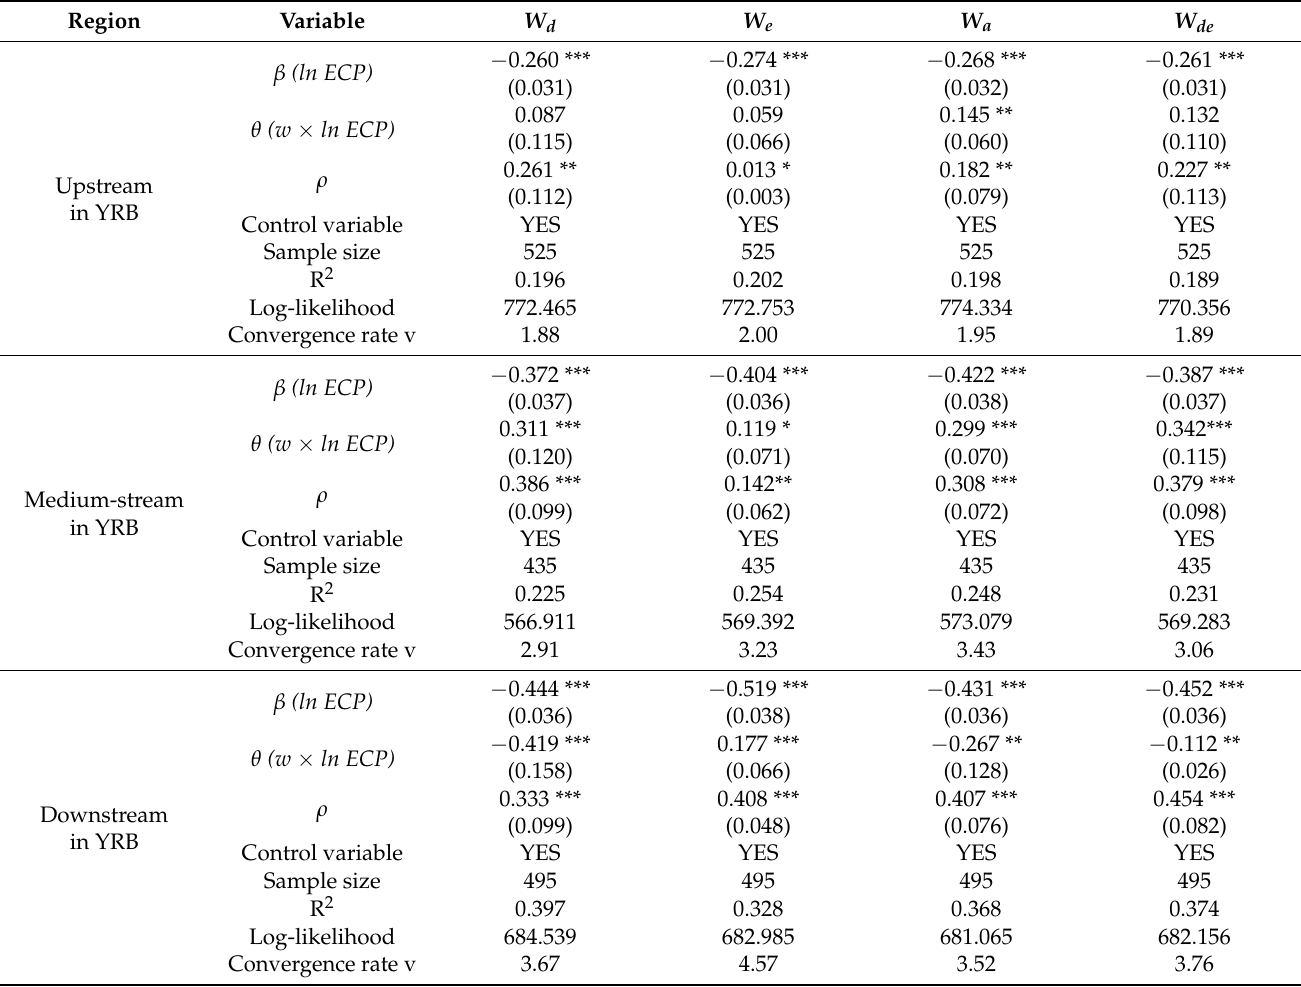
Table 5. Estimation results of regional spatial convergence model for ECP in the